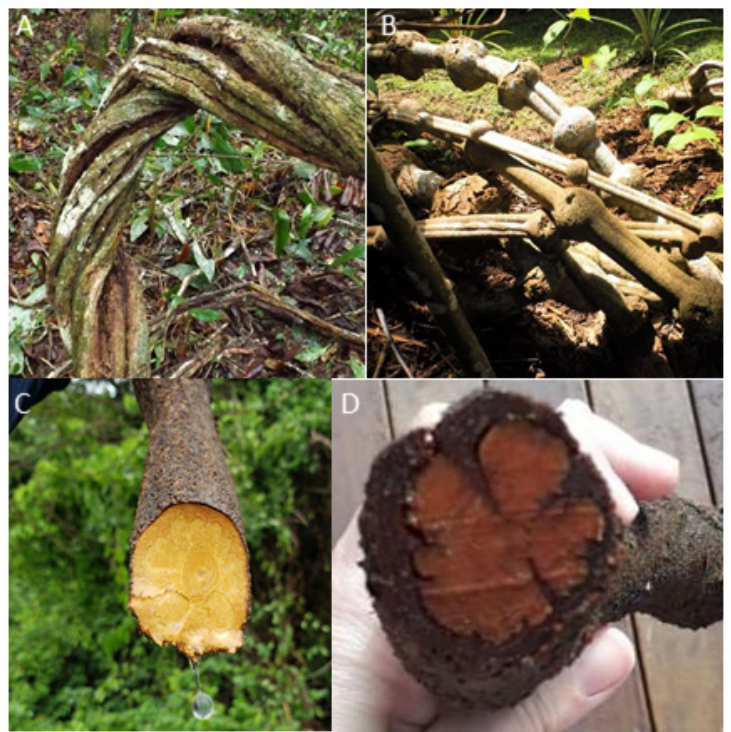
Figure 3. Different Banisteriopsis caapi types used in ayahuasca preparation: ( A ) tucunacá; ( B ) caupuri (with swollen nodes); ( C ) fresh amarelinho; ( D ) amarelinho some days after harvesting. Images taken by the authors and collaborators.